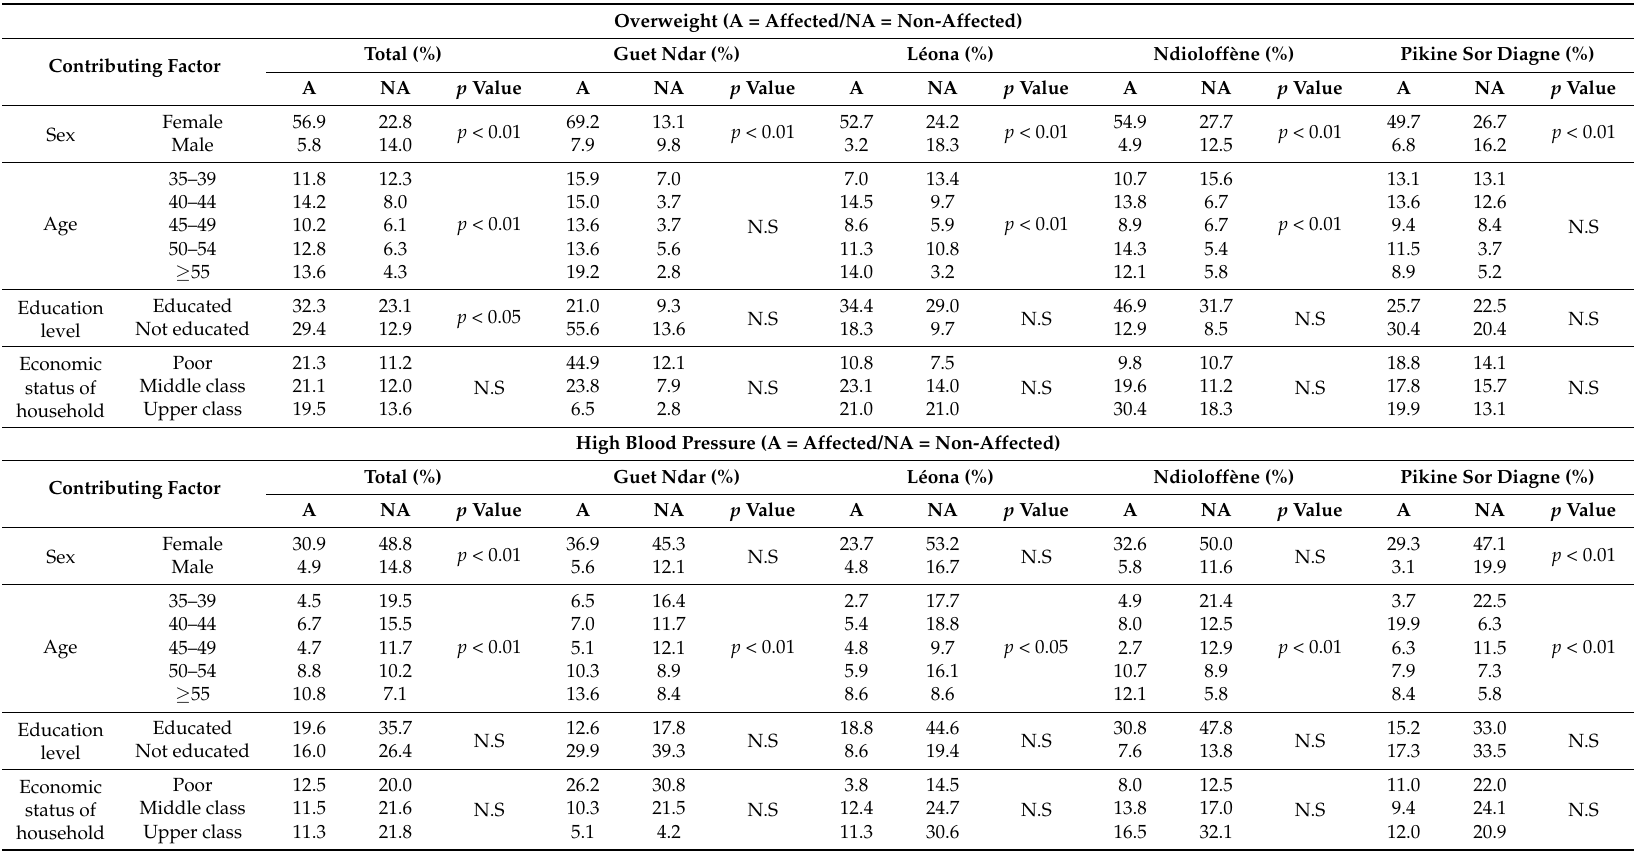
Table 4. Statistical associations between contributing factors and health